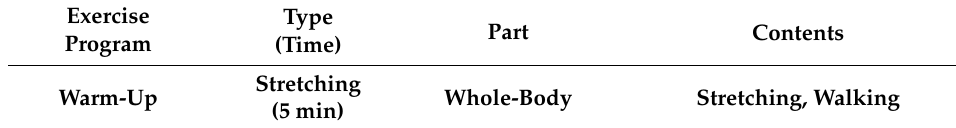
Table 2. Bodyweight-based and elastic resistance training program.